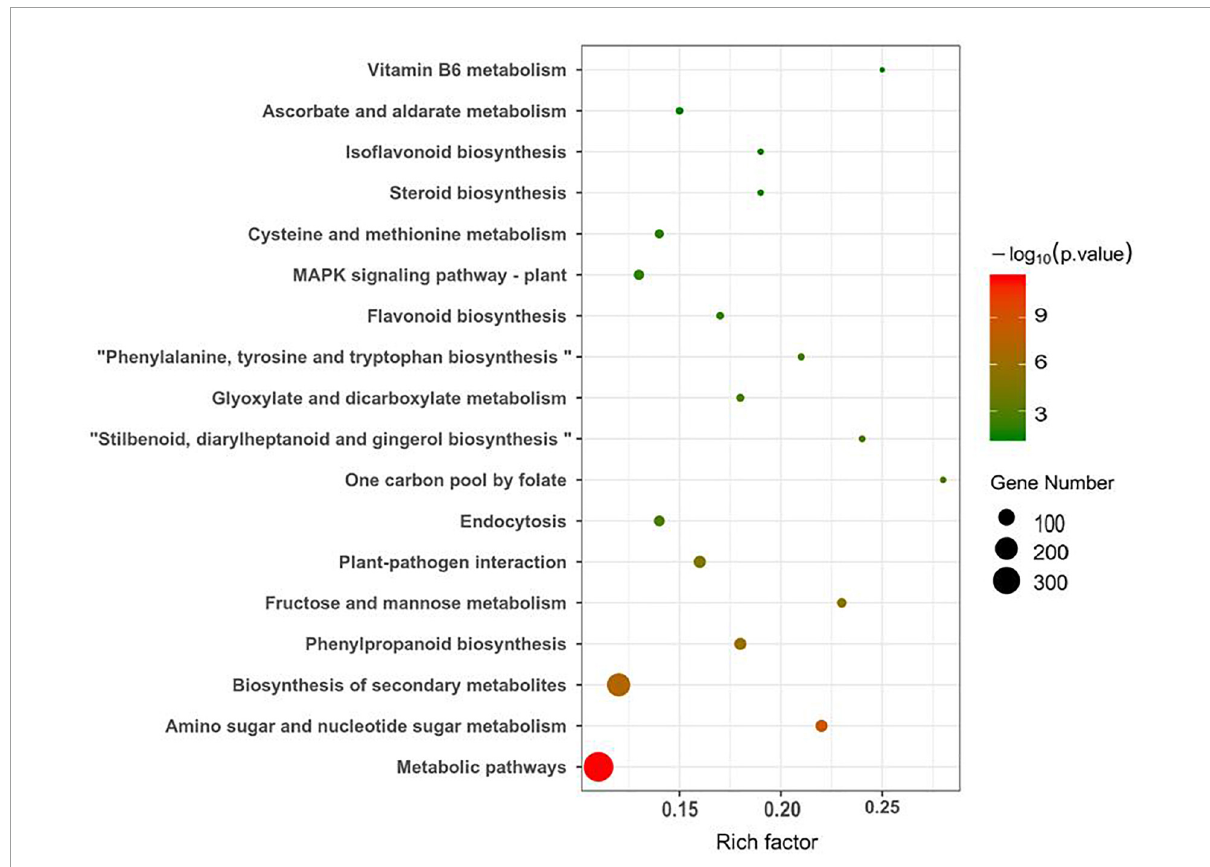
FIGURE5 Differential gene KEGG bubble